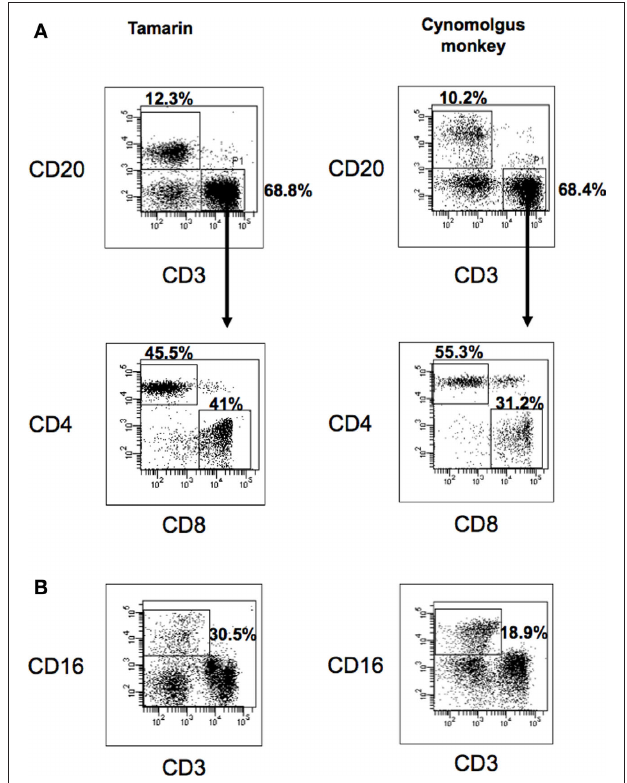
Figure 1 | Flow cytometric analysis of CD3, CD20, CD4, CD8, and CD16 expression on lymphocytes in cynomolgus monkeys and tamarins. Representative results in tamarins and cynomolgus monkeys are shown. (A) Flow cytometric analysis of CD3 and CD20 expression in lymphocytes (top panels) and CD4 and CD8 expression in CD3 + population (bottom panels) of both monkeys. (B) Flow cytometric analysis of CD3 and CD16 expression in both monkey species. The numbers denote the percentages of lymphocytes. We analyzed statistically whether these lymphocyte ratios were different between tamarins and cynomolgus monkeys by using StatView software. There were no significant differences of the lymphocyte ratios between